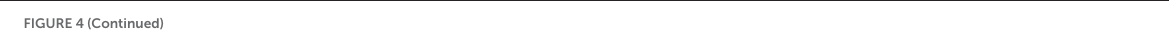
FIGURE4(Continued) representative GO terms of miRNA target genes. The dot size and color represent the gene number and p-value of the corresponding term, respectively. (C) Heatmap of GSEA NES based on the correlation coefficient of circRNAs and gene expression. HALLMARK, KEGG, and REACTOME gene sets were utilized. (D) Heatmap of Spearman’s correlation coefficient of the key circRNAs with genes involved in positive regulation of smooth muscle contraction (GO:0045987). The red rectangles indicate the target genes of circRNA-interacted miRNA. * p <